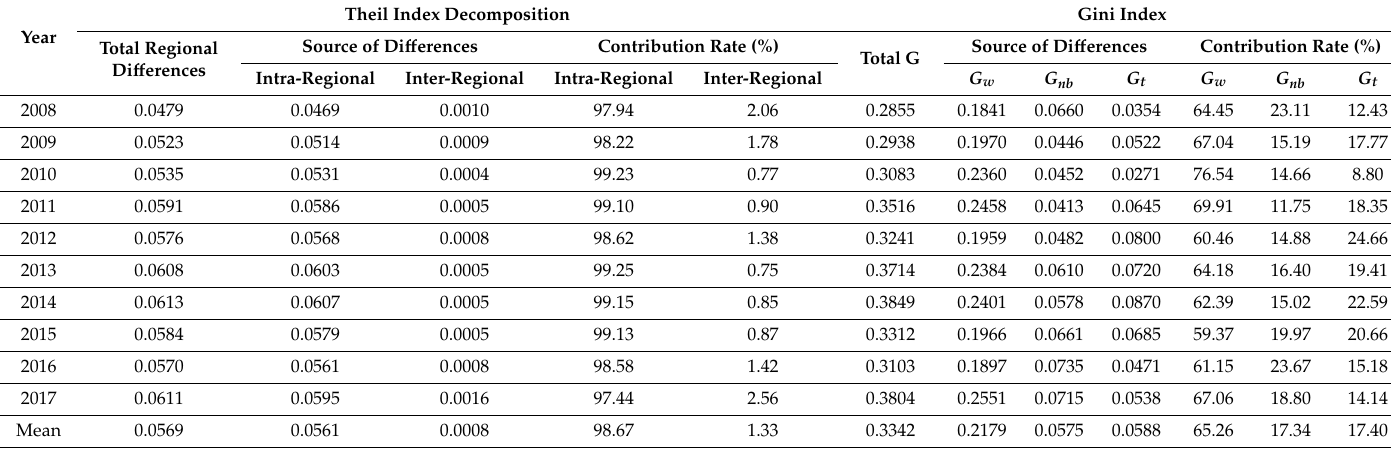
Table 2. Theil index decomposition and Gini index decomposition of regional di ff erences and their sources of allocation e ffi ciency of rural public health resources in China from 2008 to